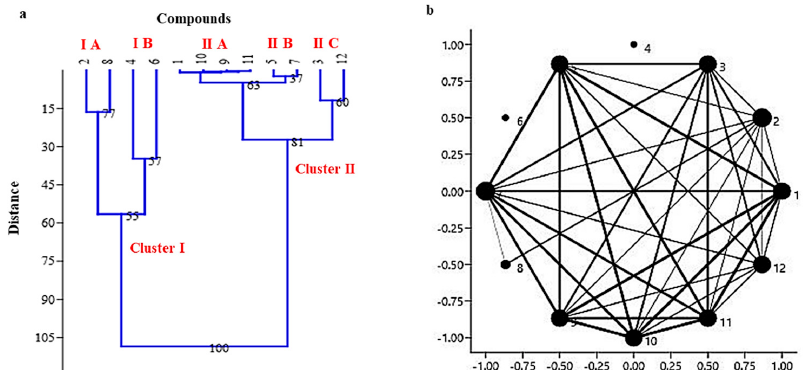
Figure 4. ( a ) Dendrogram showing the hierarchical clustering to interpret the distribution of 12 dif- ferent essential oil compounds of B. persicum , and ( b ) Network clustering to extract the densely connected but relatively isolated subnetworks component of 12 different essential oil compounds of B. persicum